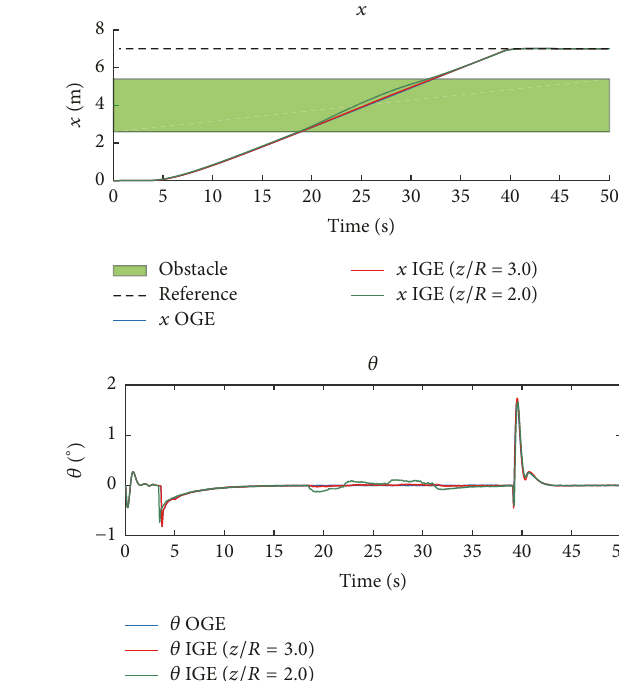
Figure 20: Feedforward controller: flying over obstacle.